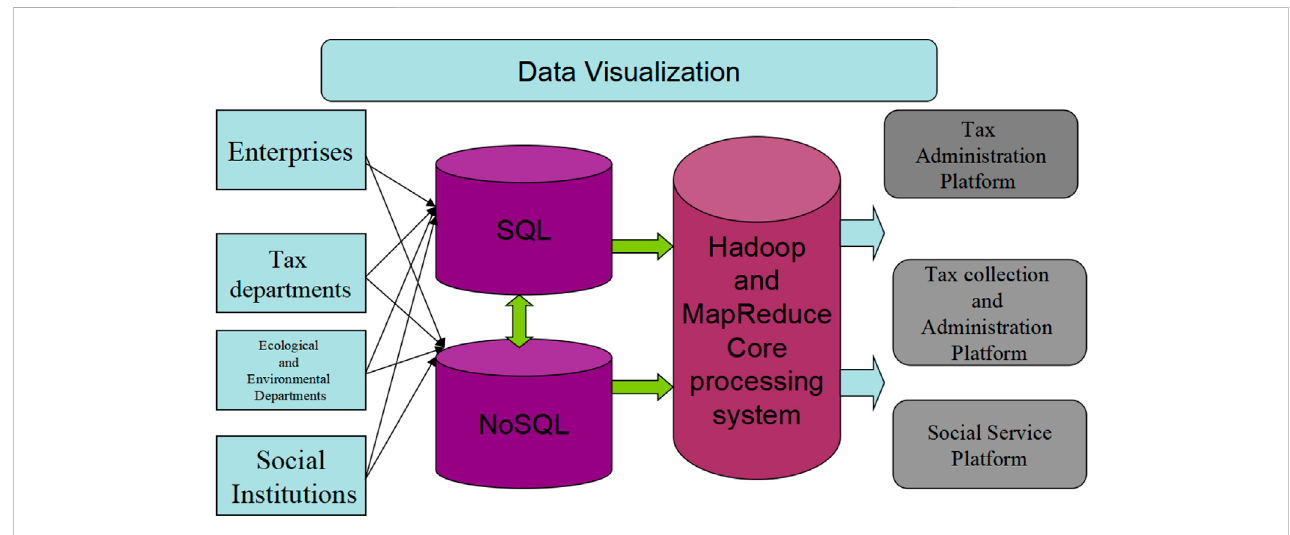
FIGURE 7 Environmental protection tax governance data